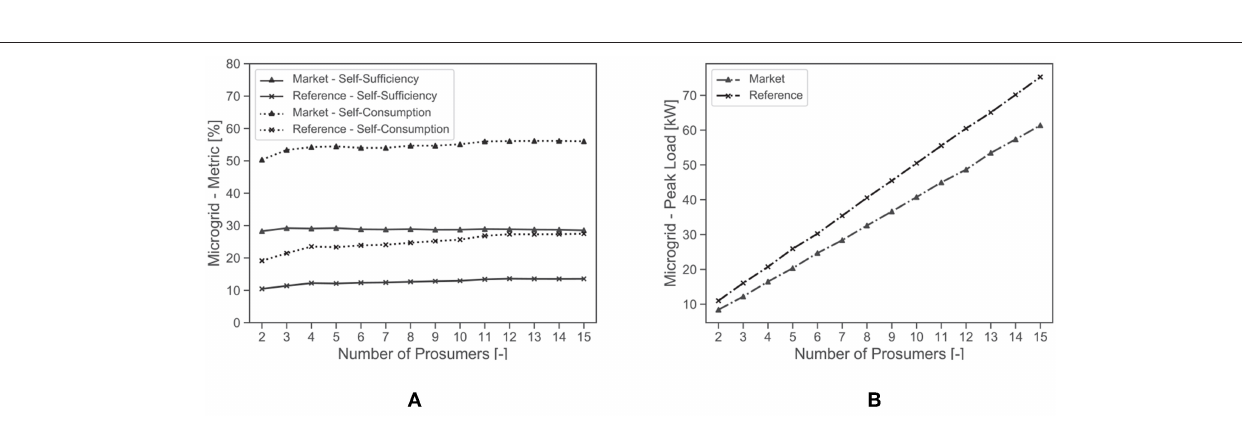
FIGURE 7 | Metrics of scenario subgroup B1 at the microgrid level, (A) self-sufficiency and self-consumption, (B) peak load.